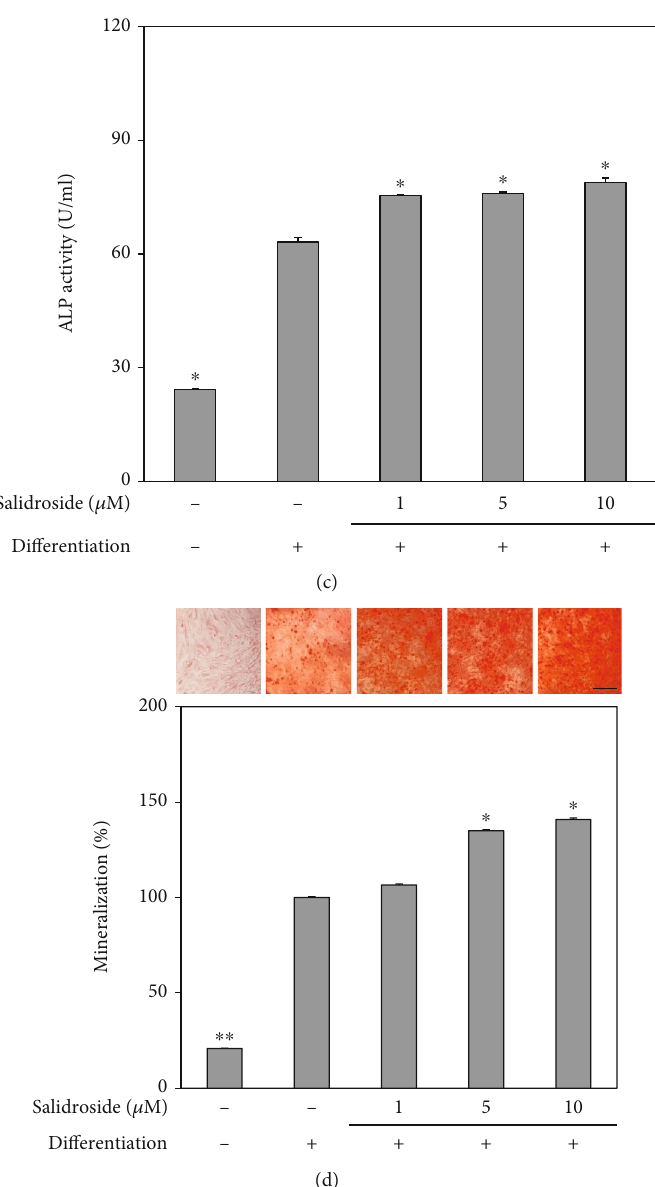
Figure 6: E ff ect of salidroside on the osteogenic di ff erentiation of hBM-MSCs. Viability of the (a) noninduced and (b) osteo-induced cells was measured after 72h and 5 days, respectively. Cells were seeded ( 1 × 10 3 ) in 96-well plates with di ff erent concentrations (0, 1, 5, and 10 μ M) of salidroside and 10% DMSO as vehicle (0, 0.01, 0.05, and 0.25% fi nal concentrations). Cell viability was compared to untreated control kept in culture medium only and given as relative percentage (a). hBM-MSCs were osteo-induced at 100% con fl uence without or with salidroside treatment (1, 5, and 10 μ M) (b). E ff ect of salidroside (1, 5, and 10 μ M) on the cellular ALP activity of osteo-induced hBM-MSCs was measured with a spectrophotometric enzymatic activity assay at day 7 of di ff erentiation (c). E ff ect of salidroside on extracellular calci fi cation was examined in osteo-induced hBM-MSCs without or with salidroside (1, 5, and 10 μ M) treatment (d). At day 14 of di ff erentiation, hBM-MSCs were stained with Alizarin Red. Images of cells show stained calcium deposits (upper panel). Mineralization levels were calculated by the colorimetric quanti fi cation of the dye removed from the wells (lower panel) and given as percentage of the untreated di ff erentiated control group. ∗ p < 0 : 05 and ∗∗ p < 0 : 01 vs. the untreated di ff erentiated control group. Scale bar: 25 μ